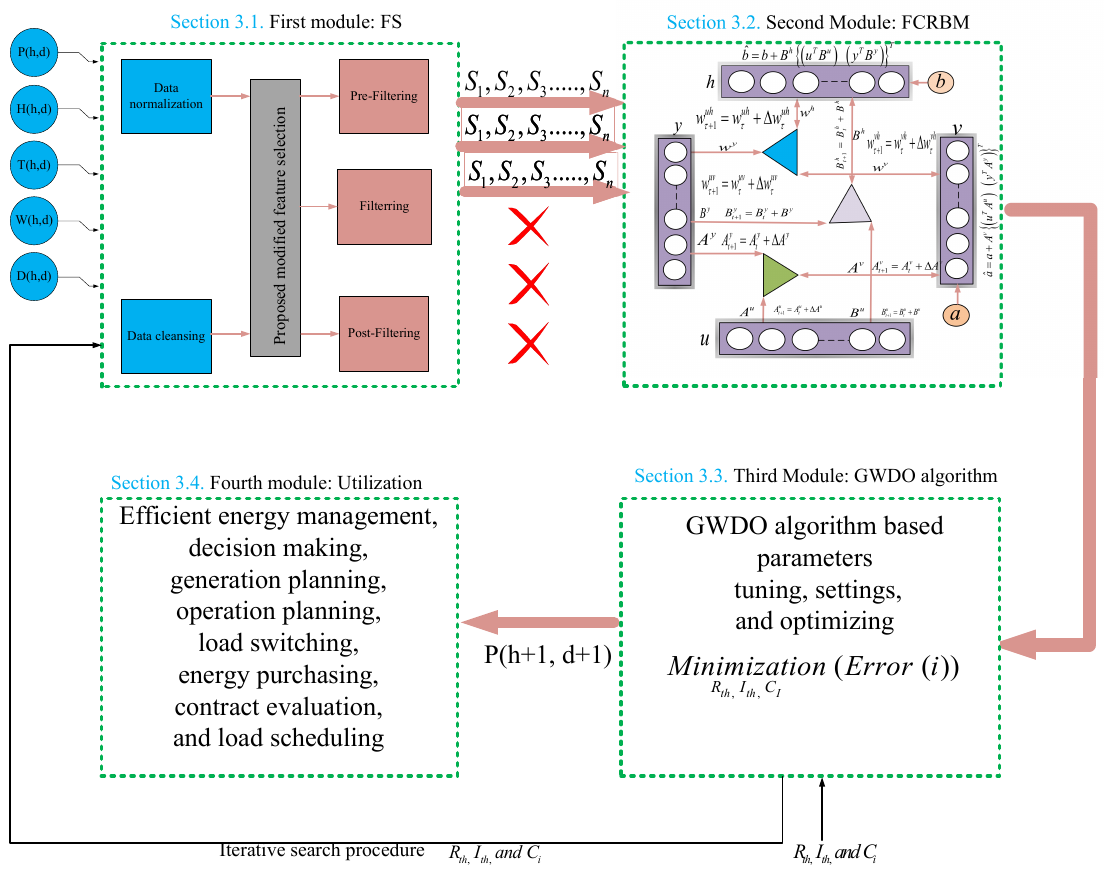
Figure 1. Schematic diagram of the proposed hybrid FS-FCRBM-GWDO framework for electrical energy consumption forecasting.